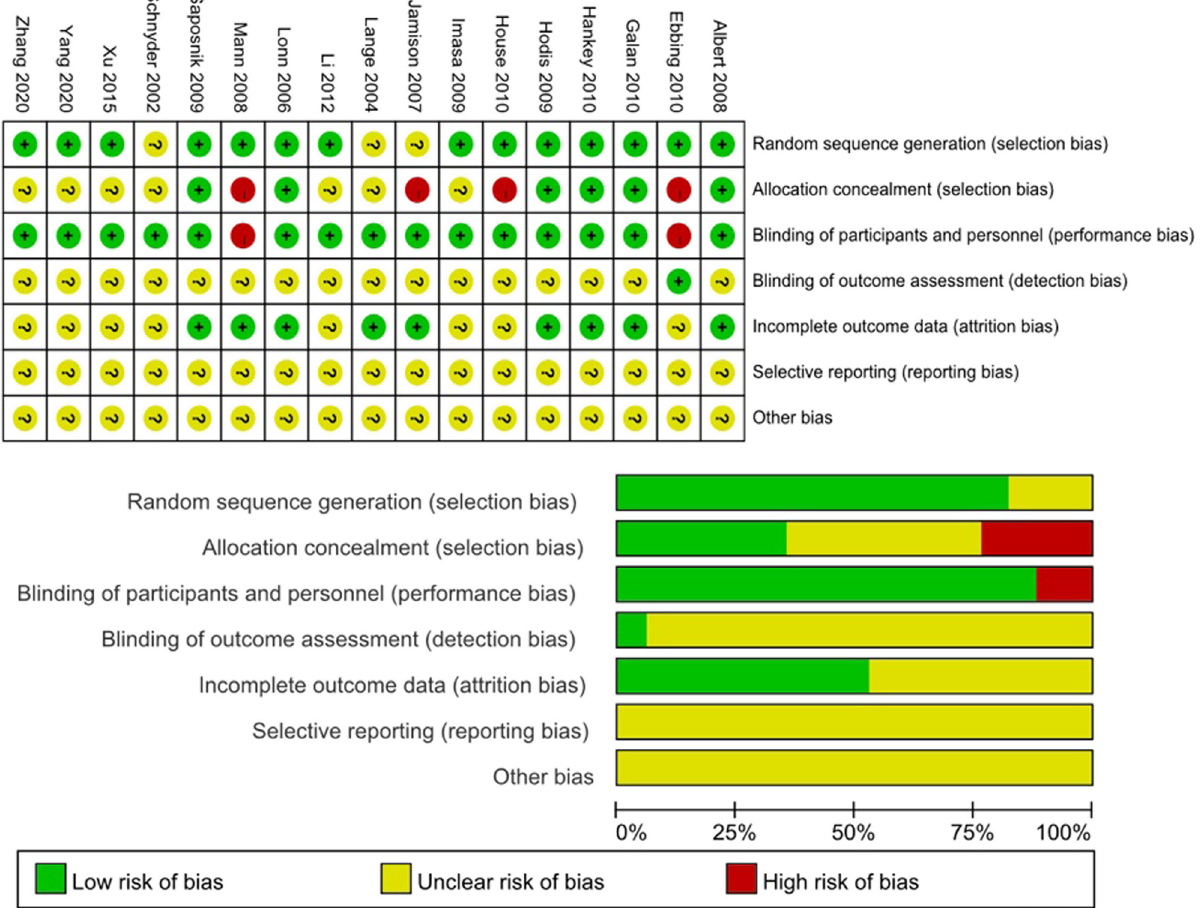
Figure 2: Degree of methodological bias in the included